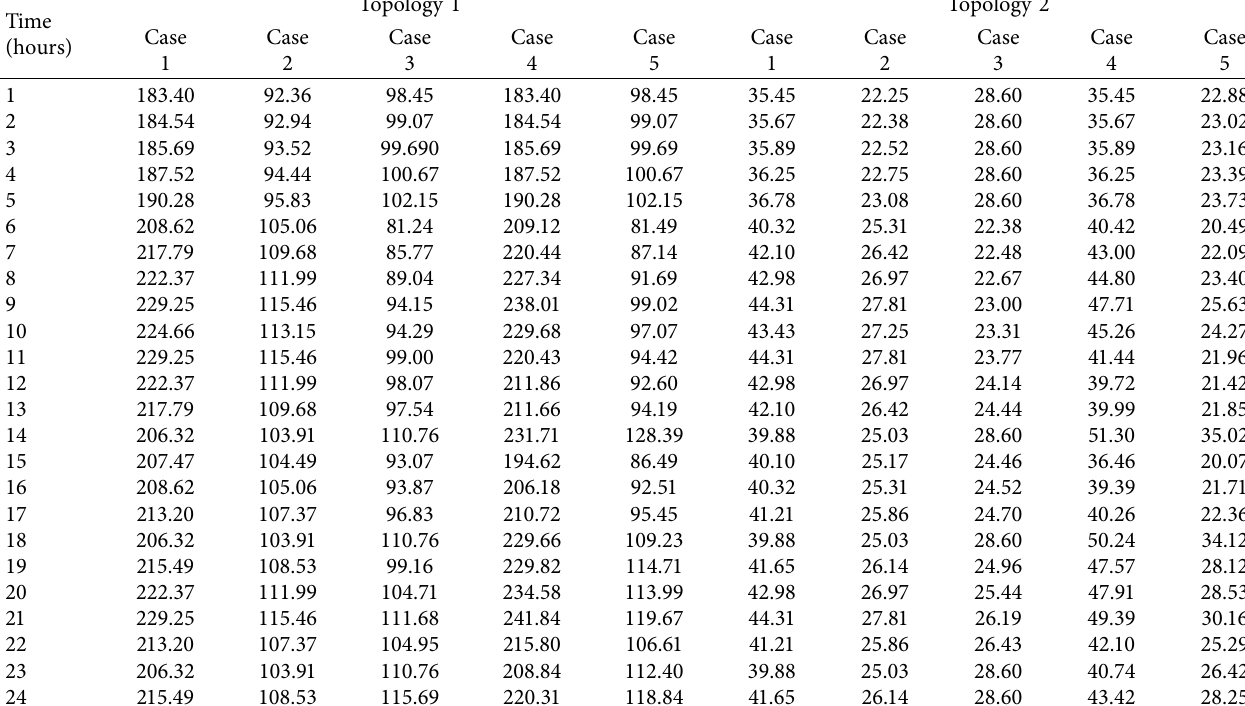
Table 8: Power loss (in kW) 69 bus system scenario